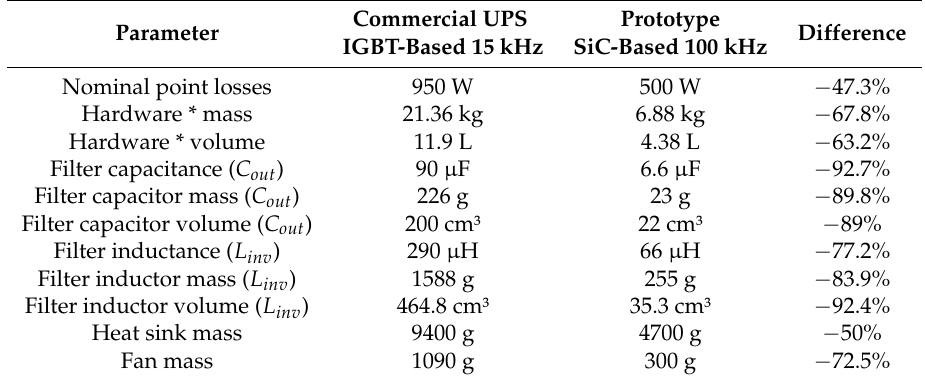
Table 7. Performance and power density comparison between the developed SiC-based prototype and